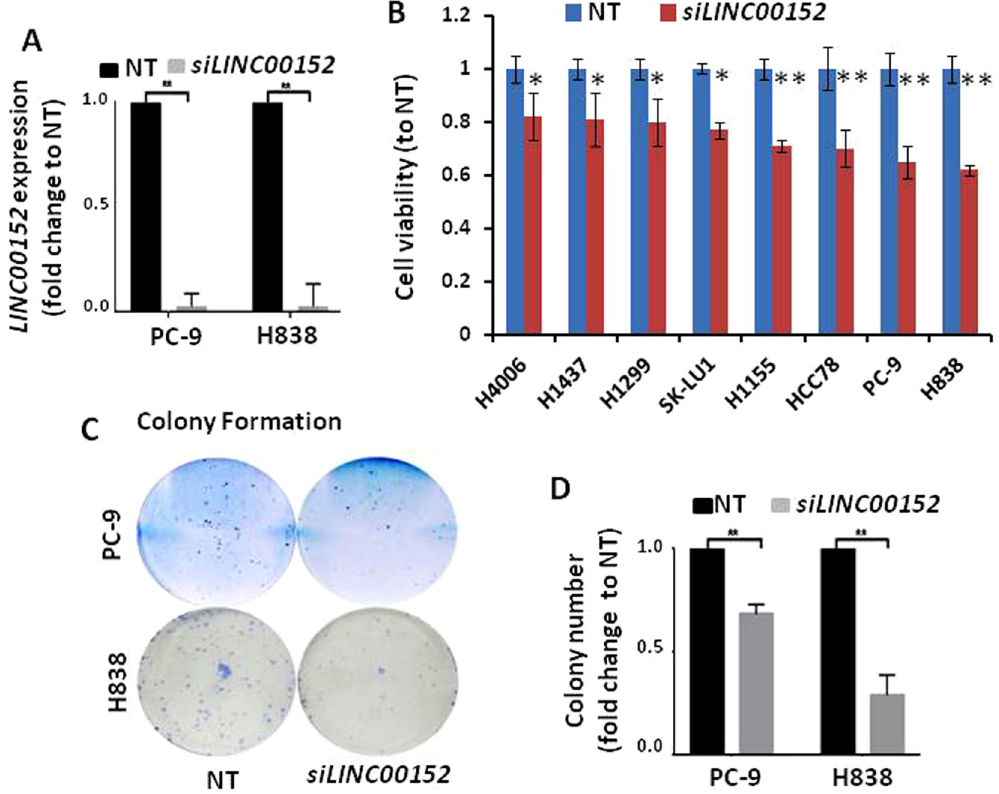
Figure 4. Effects of LINC00152 on cell viability. ( A ) LINC00152 expression was decreased more than 90% after LINC00152 knockdown with siRNA on PC-9 and H838 cells measured by RT-PCR. ( B ) Cell proliferation measured by WST-1 assays was conducted on 8 lung cancer cell lines to determine the effect on cell viability after LINC00152 siRNA transfection for 96 hours. Values indicate the mean + SD from three independent experiments. ** p < 0.01, * p < 0.05. ( C and D ) Colony formation was decreased after LINC00152 siRNA transfection on PC-9 and H838 cells. ** p <